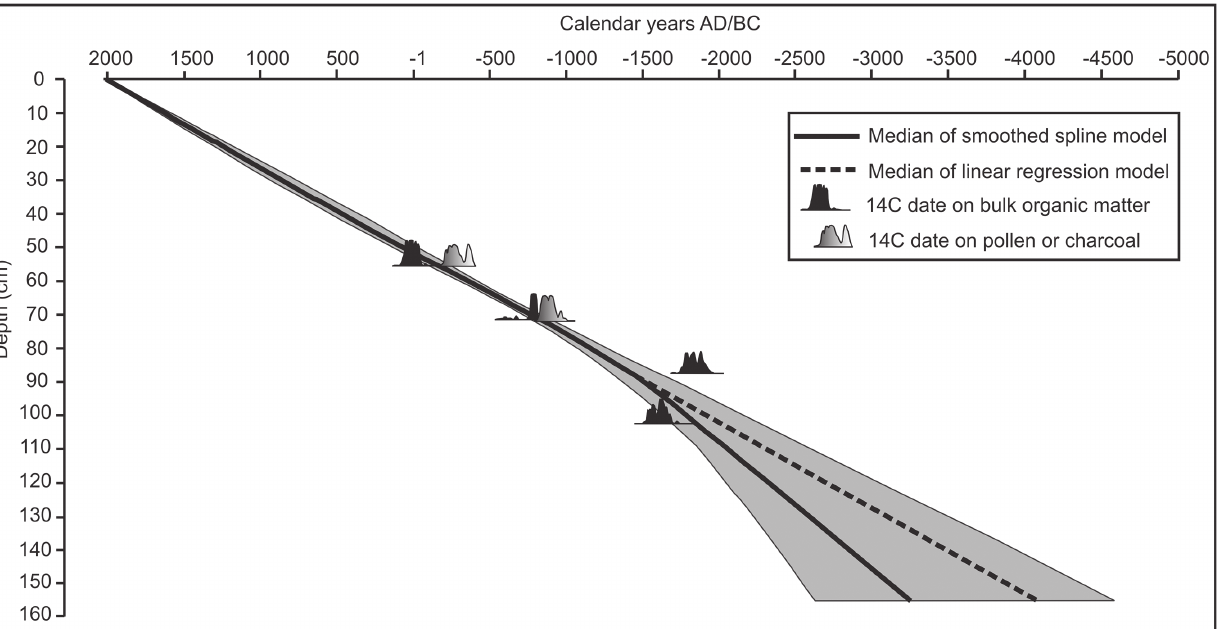
Fig 4. Age-depth model for the sequence generated using Clam (Blaauw, 2010). Two possible models, generated using a smoothed spline and linear regression, are presented. The grey envelope indicates the 95% confidence limits of the smoothed spline model which encompasses the narrower 95% confidence limits of the linear regression model. The solid black line and dashed line respectively represent the ‘ best estimates ’ of the smoothed spline and linear regression models.